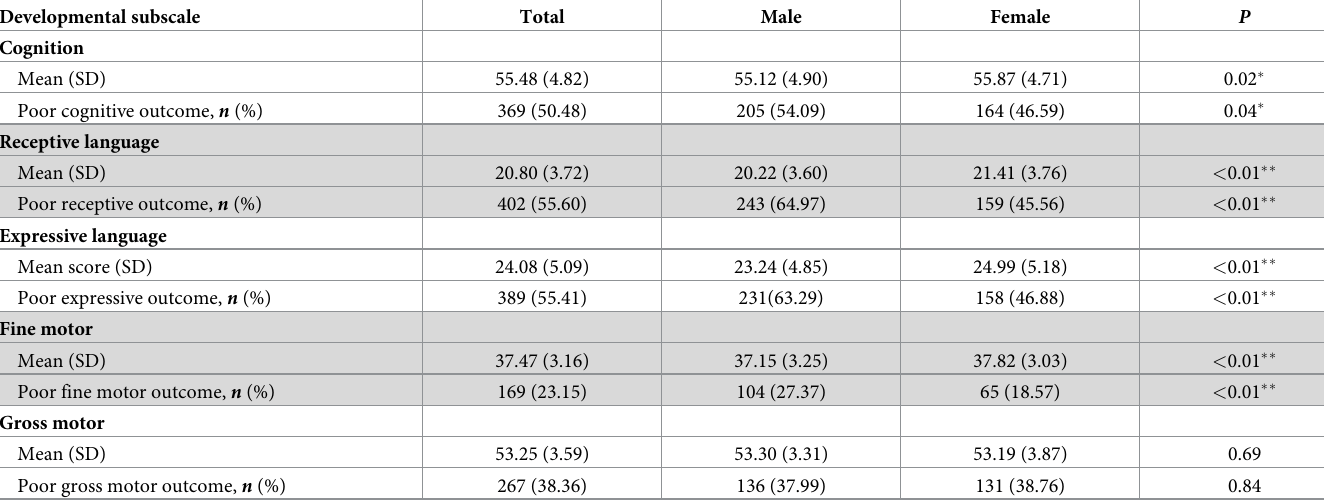
Table 2. Child developmental outcomes at 24 months of age for all children who completed at least one domain of the BSID-III ( n = 734). Developmental